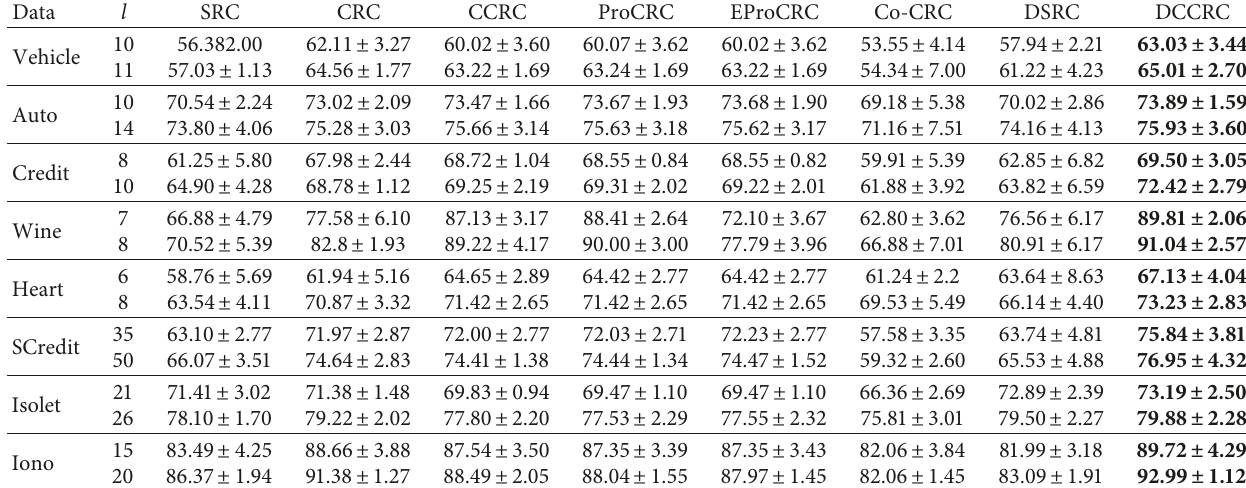
Table 4: The classification accuracies (%) of the competing methods with the corresponding standard deviations with different class-specific training samples on each UCI data